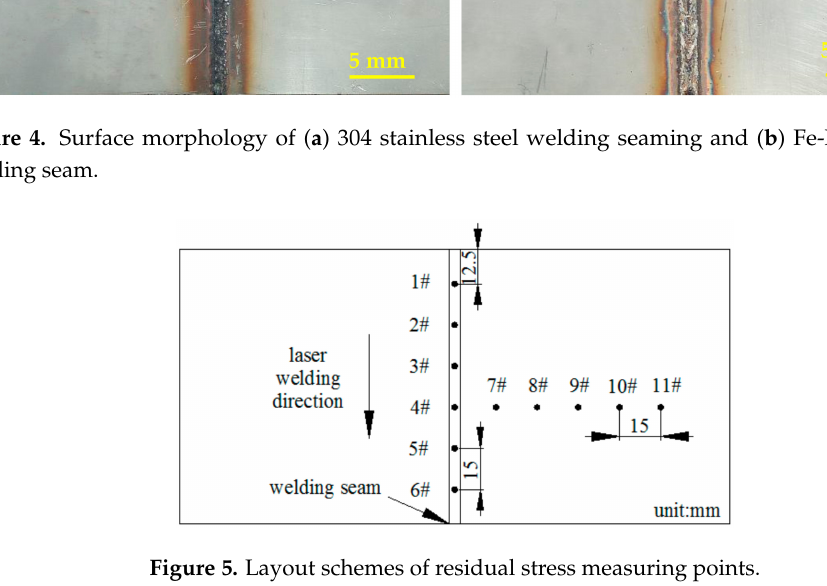
Figure 5. Layout schemes of residual stress measuring points.